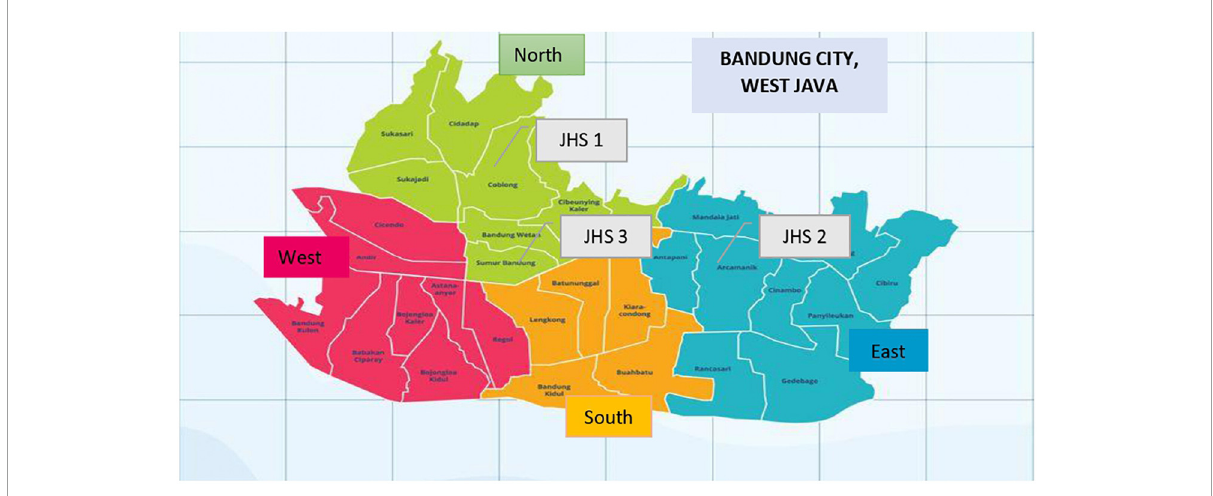
FIGURE1 The school location map